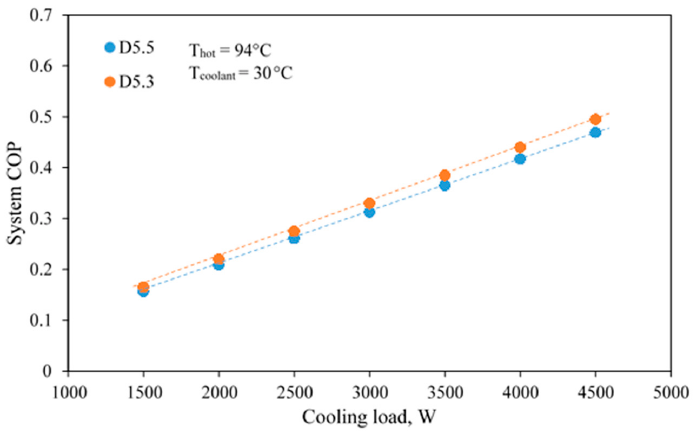
Figure 7. The system COP against cooling loads influenced by primary nozzles .